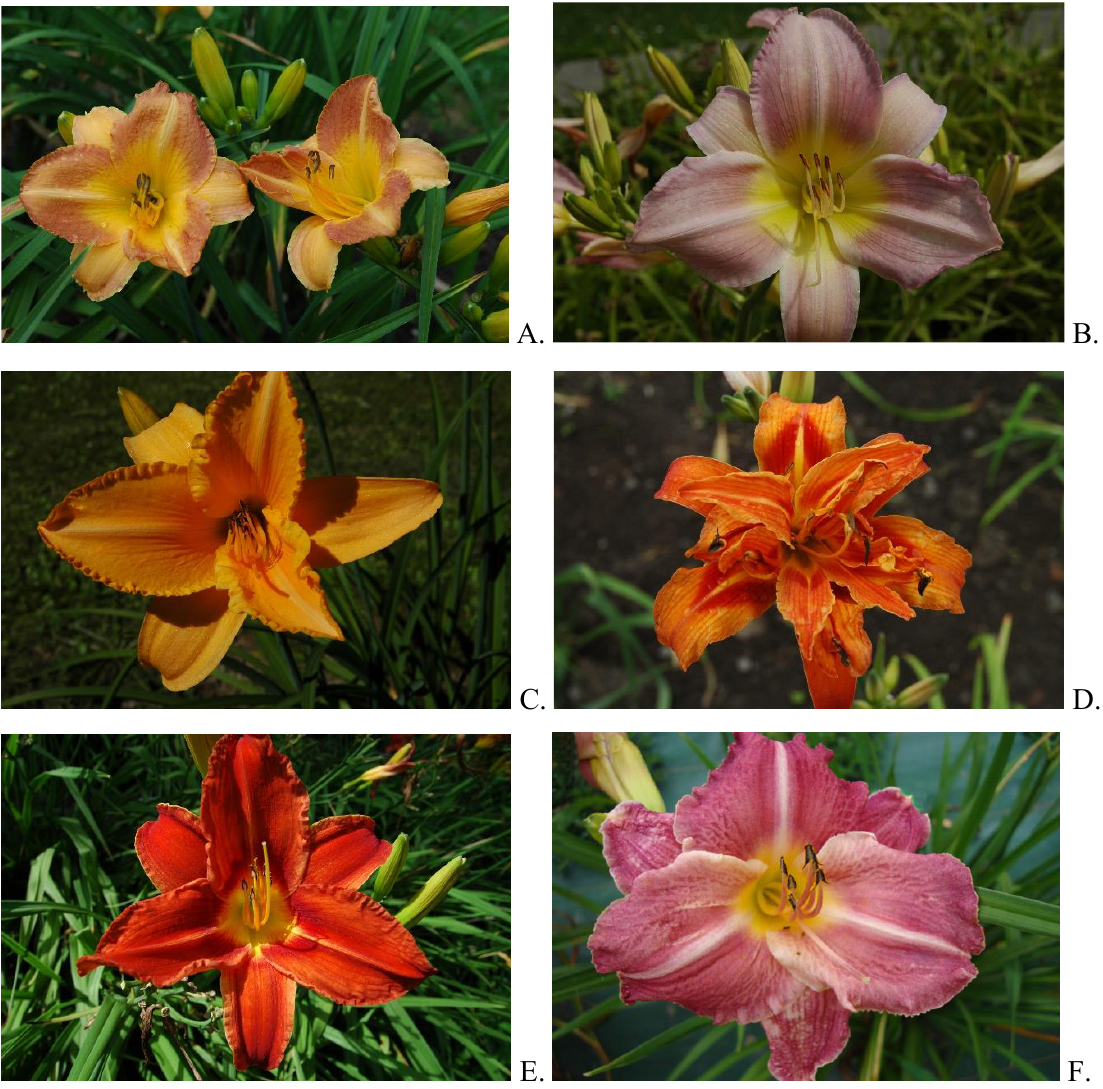
Figure 1 : Pictures of some Hemerocallis cultivars under study: A. H. ‘Bożena’, B. H. ‘Catherine Woodbuery’, C. H. ‘Danuta’, D. H. fulva , E. H. ‘Rebel Cause’, F. H. ‘Jaskółka’.